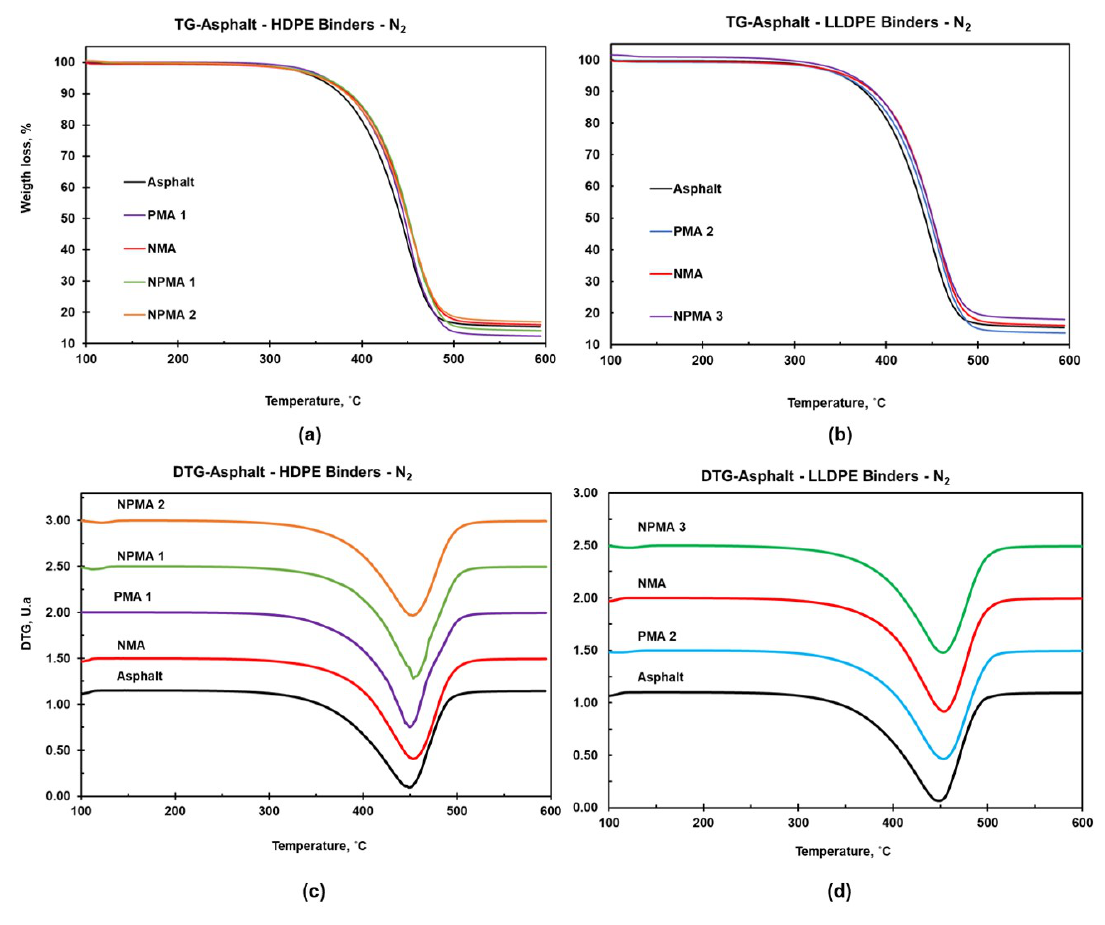
Fig. 2. Thermogravimetric analysis results under N 2 atmosphere. (a) TG curves for asphalt modified by HDPE; (b) TG curves for asphalt mixtures by LLDPE; (c) DTG curves for asphalt modified by HDPE; (d) DTG curves for asphalt mixtures by